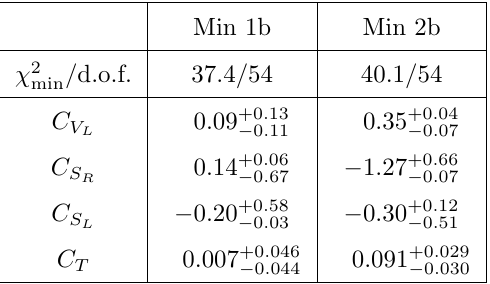
ratios and the F D (cid:3) polarization, using L R D ( (cid:3) )